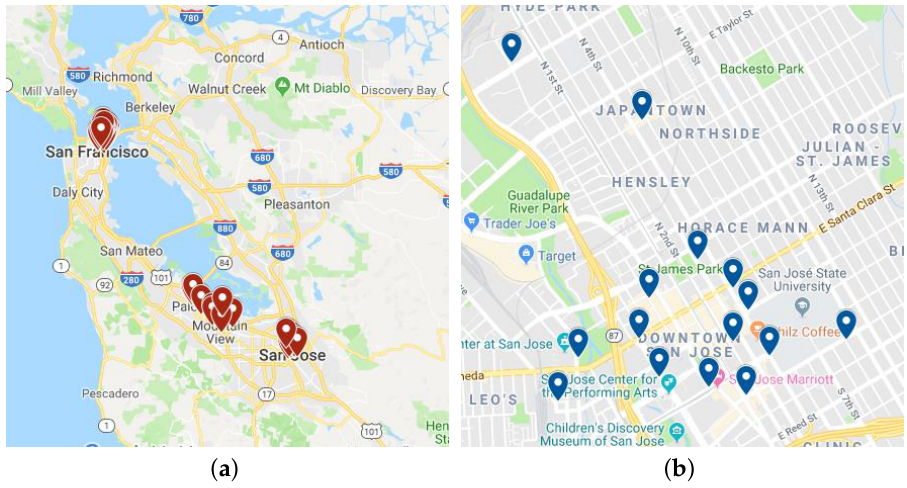
Figure 3. Map of the Bay Area bike sharing system. ( a ) Stations in Bay Area; ( b ) Stations in our